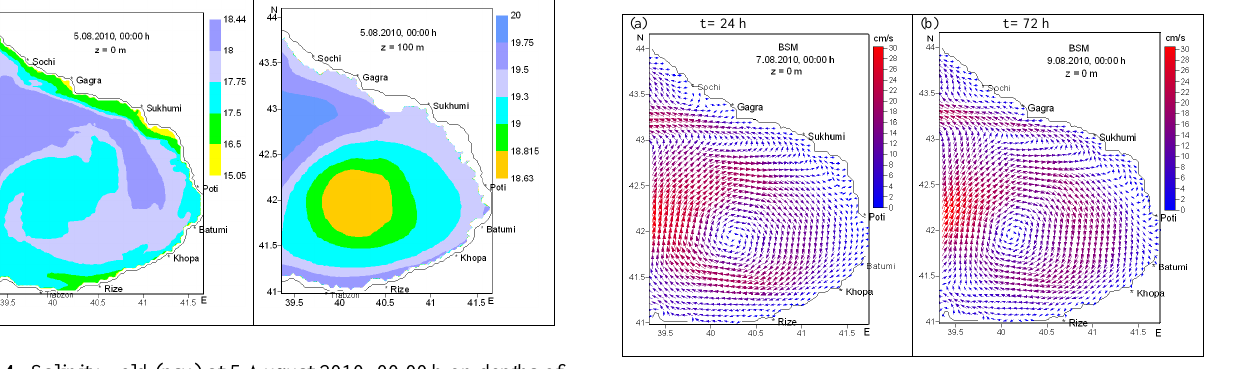
Fig. 5. The surface current fields predicted by RM-IG at 24 h (a) and 72 h (b). (the forecasting period is 6.08.2010, 00:00 h – 9.08.2010, 00:00 h).